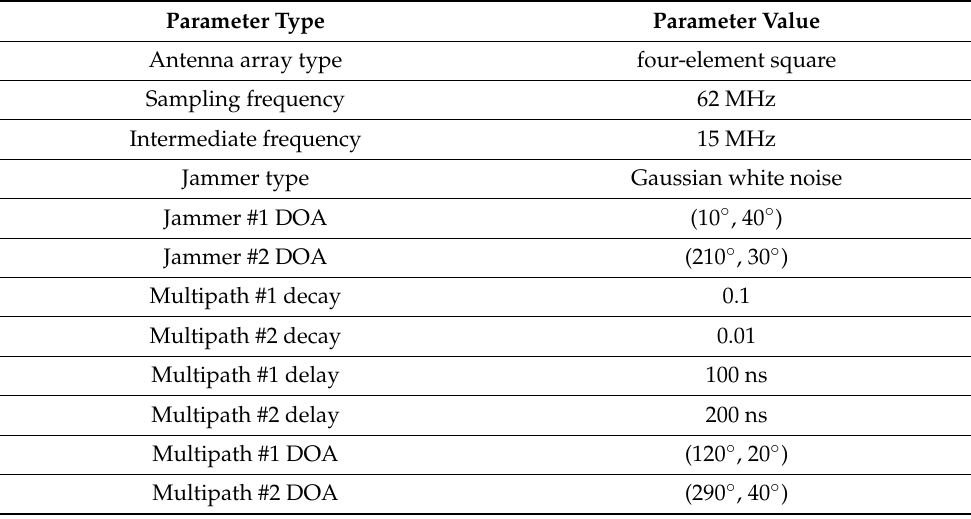
Table 1. Public parameter settings.